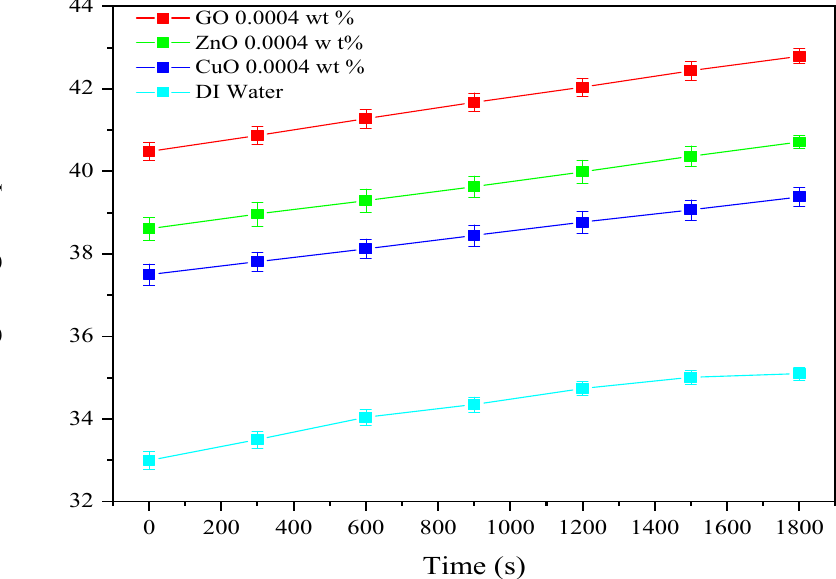
Figure 5. Average change in the temperature profile of DI water base CuO, ZnO, and GO nanofluids at 0.0004 wt % concentration .